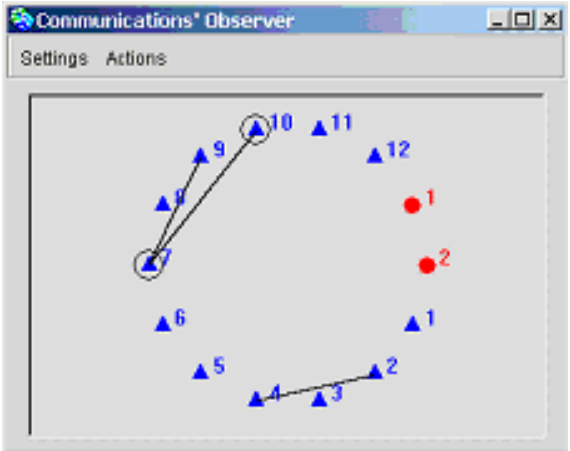
Fig. A2.9. The CORMAS Communication observer showing the exchange of water between agents in Limbukha Model (circle represents communicating agents). Blue triangles represent the Farmer agents, red triangles represent the Village